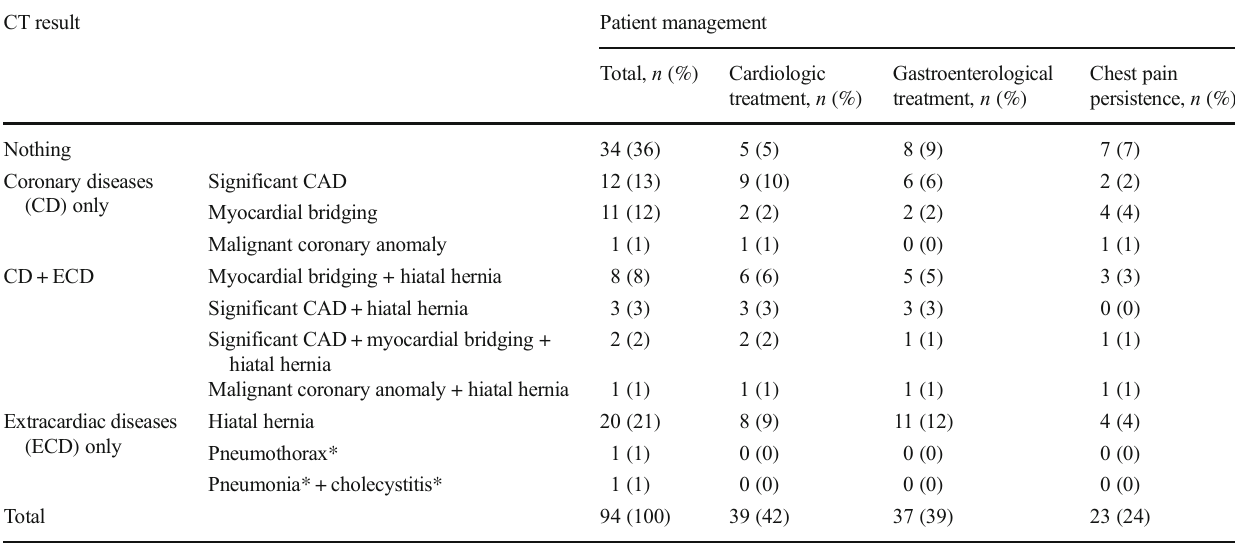
Table 2 Association between CT results and patient management in the 94 patients with available follow-up CT result Patient